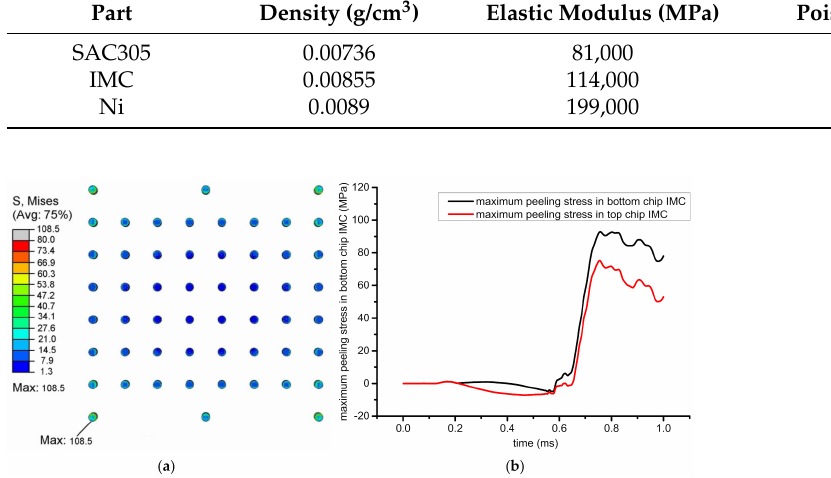
Figure 3. ( a ) Von Mises stress distribution of solder joint; ( b ) maximum peeling stress curves in a microbump joint during the impact load.